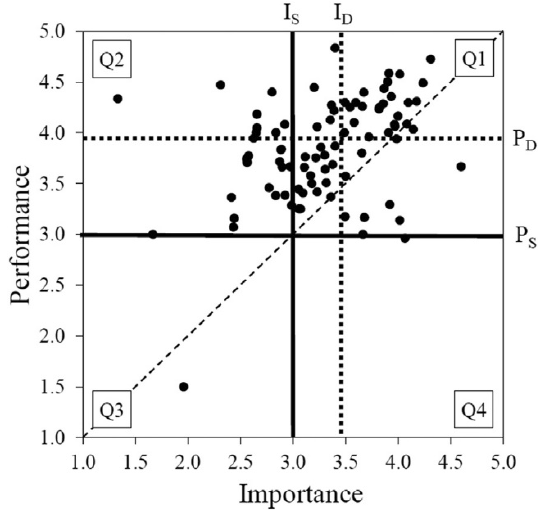
Figure 5. The line of different thresholds within the IPA plot. Note: Graphical comparison of scale–centered (IS − PS) and data–centered (ID − PD) approaches [22] in identifying the IPA quadrants.